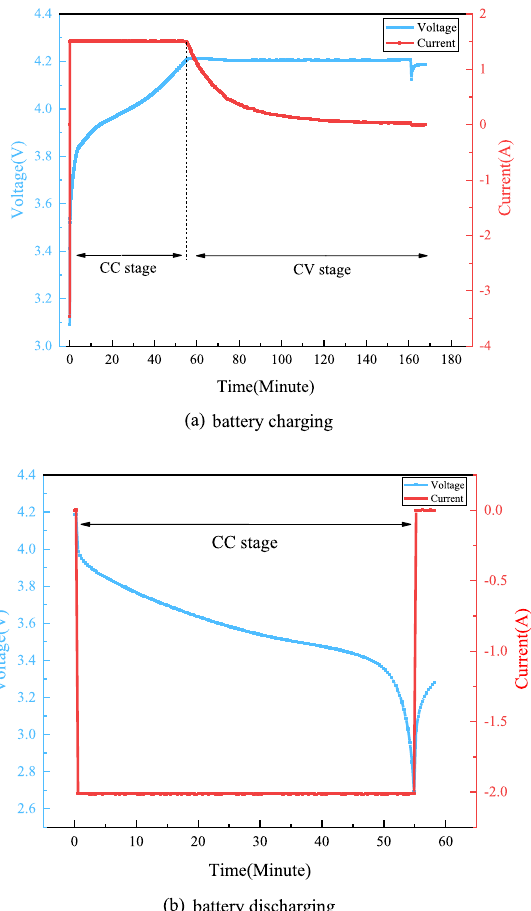
Fig. 1 Terminal voltage and terminal current for charging and discharge of B0005